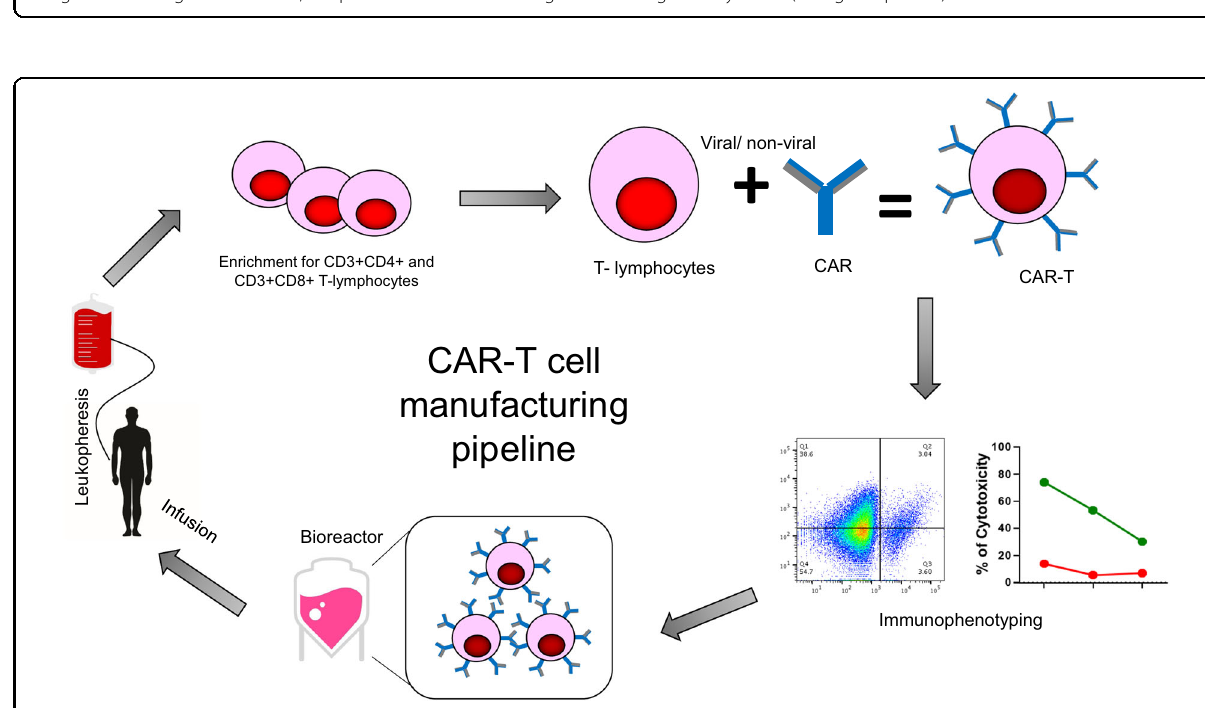
Fig. 3 The depiction of different generations of CAR T cell. First-generation CAR contains basic design with the ScFV portion of monoclonal antibody at the ectodomain, hinge at the transmembrane domain and CD3 ζ signaling molecule at the endodomain. Second- and third-generation CARs comprise additional one or two co-stimulatory molecule/s in the endodomain, respectively. Fourth-generation CAR (TRUCK) follows the basic design of second-generation CAR, coupled with an added transgene encoding for a cytokine (transgenic